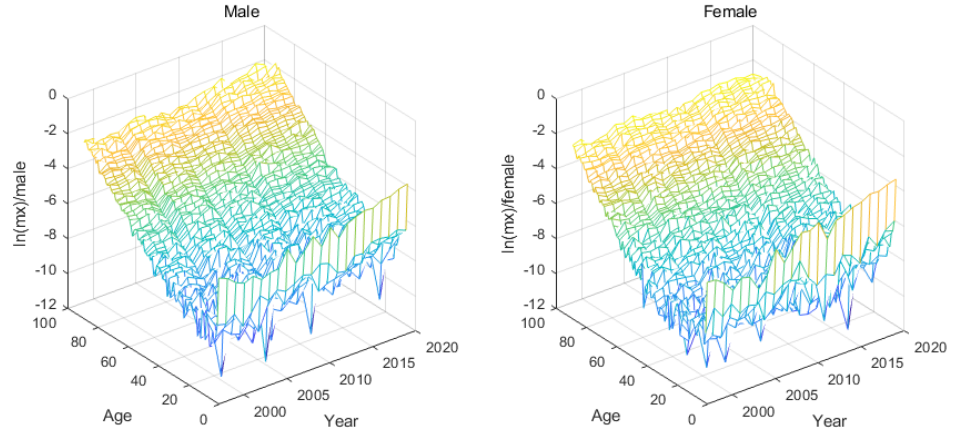
Figure 1. All age mortality of both